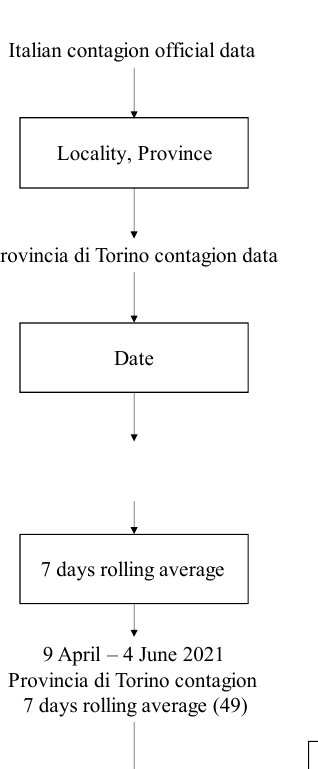
Figure 4. Data selection and elaboration process adopted in phase 2.